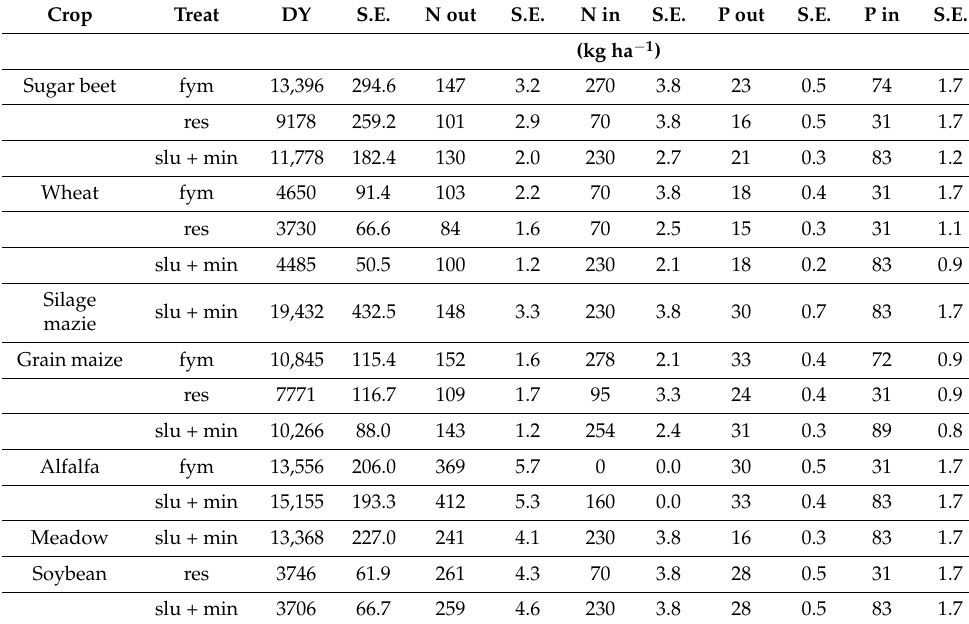
Table A1. Mean value of dry yield (DY), N output (N out), N input (N in), P output (P out), and P input (P in) according to crop and treatment (Treat) in long-term experiments. res: crop residues incorporation; fym: farmyard manure; slu+min: slurry + mineral fertiliser application;